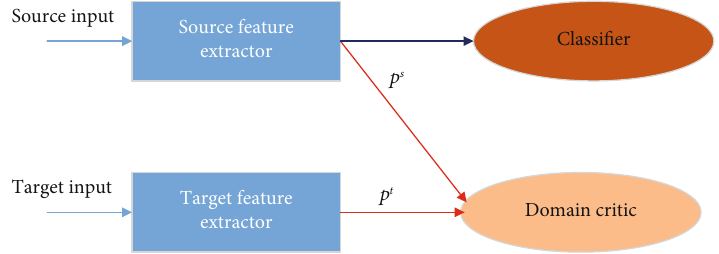
Figure 2: The overall structure of